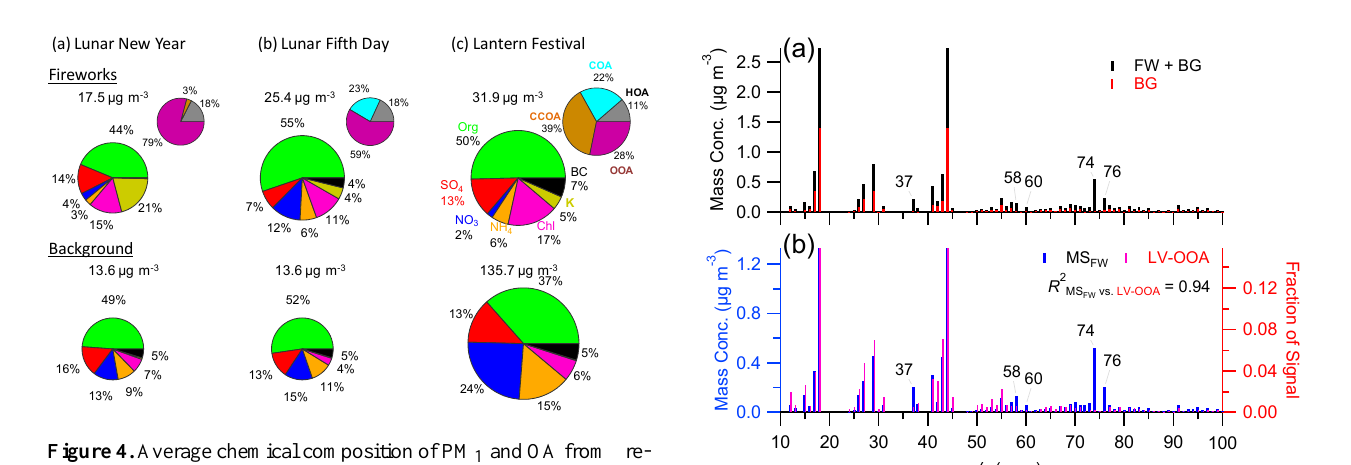
Figure 4. Average chemical composition of PM 1 and OA from fire- works and background conditions during three FW events.